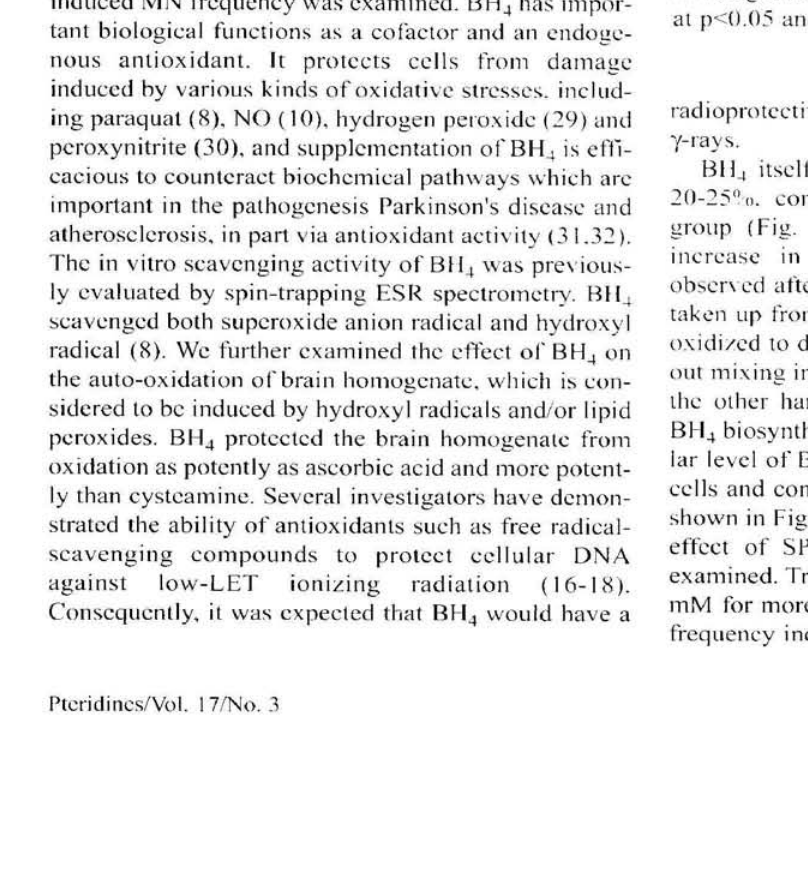
Figure 5. Influence of N-acetyl-5-hydroytryptamine (NAS) on the reducing effect of sepiapterin on the micronucleus (MN) frequency induced by 5 Gy γ-rays in RAW264.7 cells. RAW264.7 cells were incubated with 1 mM SP for 18 h in the presence or the absence of NAS and then irradiated. After irradiation, the cells were kept for 24 h under normal growth conditions before the quantification of micronuclei. Each point indicates the mean ± SE (n=500). The relative MN fre- quency was calculated with respect to the MN fre- quency of the group irradiated with 5 Gy γ-rays alone, taken as 100% at each time. ***, Significantly differ- ent from the radiation-alone control at p<0.005, # and ###, significantly different from the SP-treated group at p<0.05 and p<0.005.